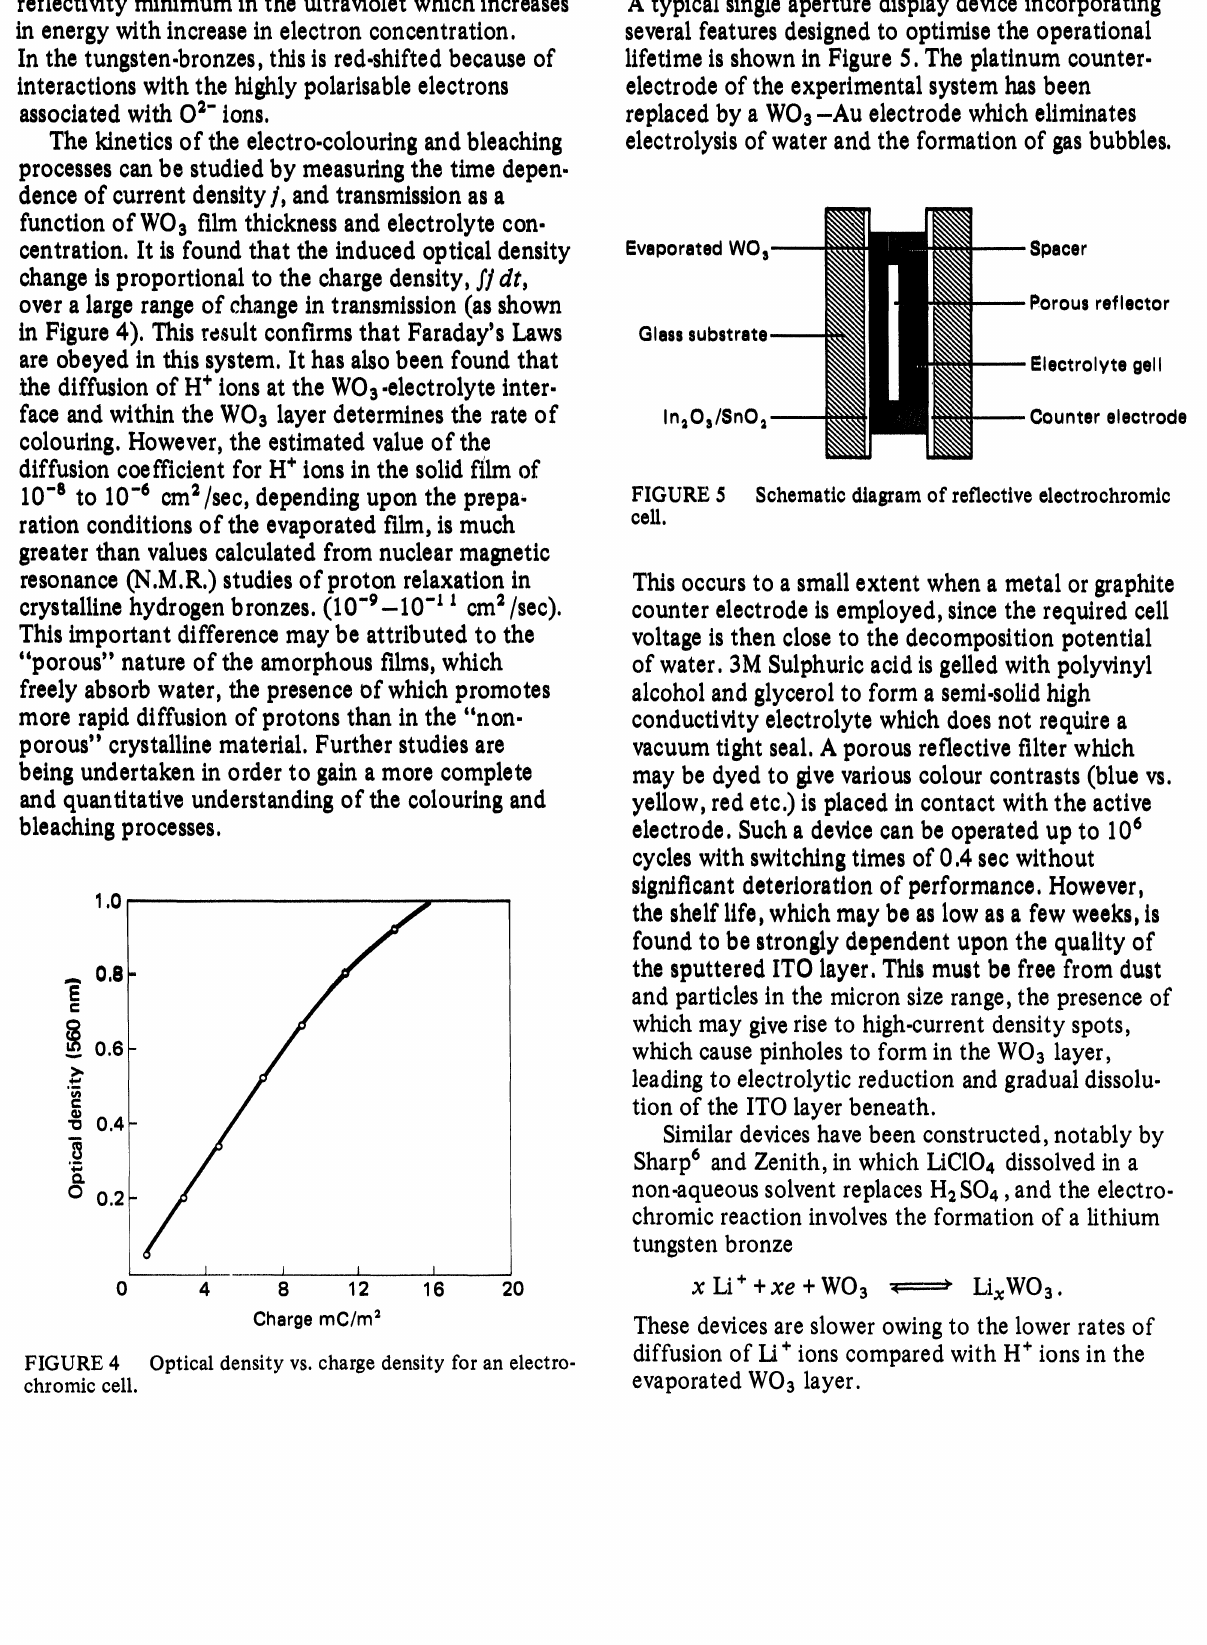
Schematic diagram of reflective electrochromic